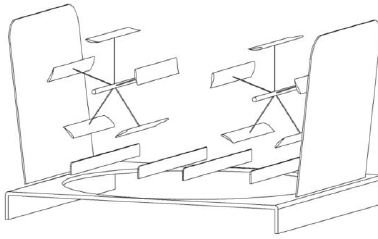
Figure 9. Iso-metric view of the augmented exhaust air energy recovery turbine.